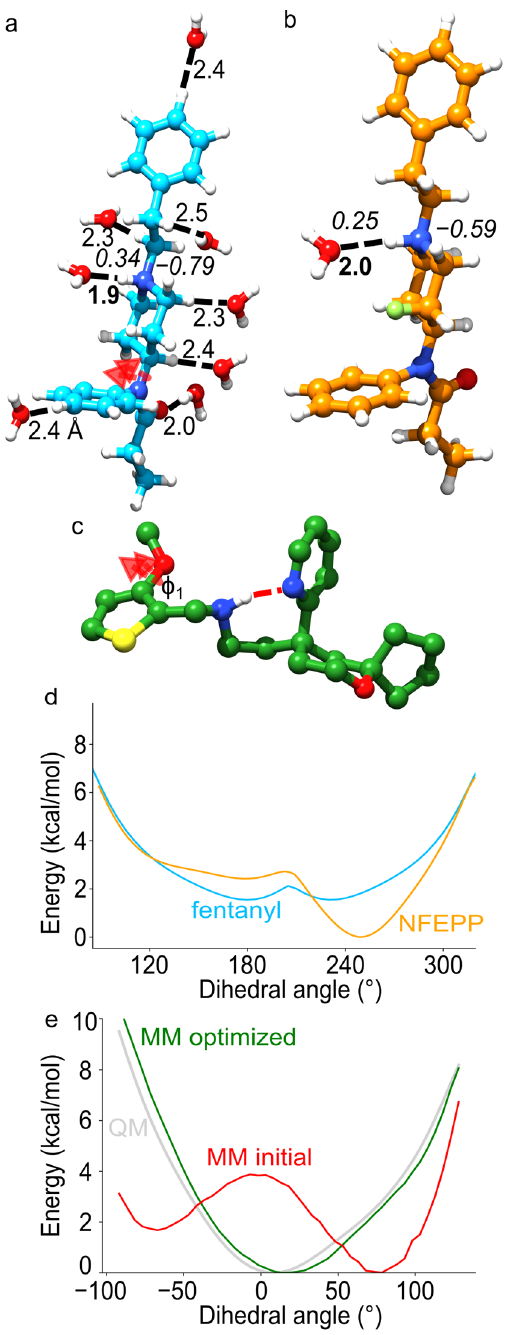
Figure 7. Force-field parameterization of fentanyl, NFEPP and oliceridine. ( a ) Illustration of QM interaction distances (regular fonts) and atomic partial charges (italic fonts) for selected sites of fentanyl. Note that the protonated amine can H-bond to water. The arrow indicates the bond for which we illustrate in panel d the torsional energy profile. ( b ) H-bond distance and partial charge values for the charged amine group in NFEPP. ( c ) Coordinate snapshot from MM MD of oliceridine [88] illustrating an internal H-bond (red dotted line) sampled between the piperidine and secondary amine nitrogen atoms. Dihedral angle Φ 1 is flexible and required force-field parametrization. ( d ) Illustration of the potential energy scans for a bond twist parametrized for fentanyl and NFEPP. Potential energies, taken relative to the energy of the equilibrium geometry, were computed with MM parameters derived in Ref. [87]. ( e ) Potential energy scans computed for angle Φ 1 . The initial MM profile is colored red, QM target profile, gray, and MM optimized, green. Panel e is based on data published in Ref [88]. Molecular graphics in panel a, b and c were created with UCSF Chimera 1.14 [23], whereas the text, arrows and dotted lines were added with Inkscape 1.0. Plots in d and e were generated using Python’s matplotlib package [89].